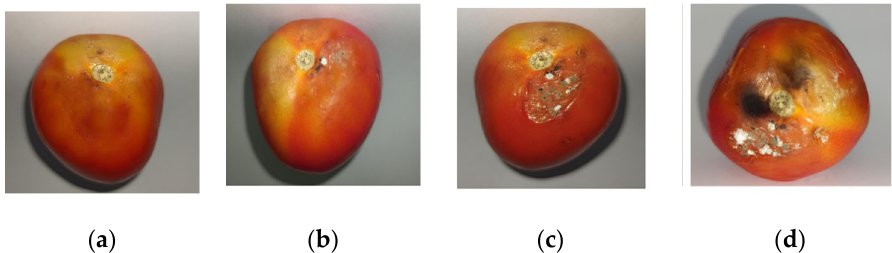
Figure 3. Hedonistic damage scale used for scale of the tomato, where ( a ) no damage (0% damage), ( b ) mild damage (10%–15% damage), ( c ) moderate damage (25%–50% damage), and ( d ) severe damage (>50% damage).